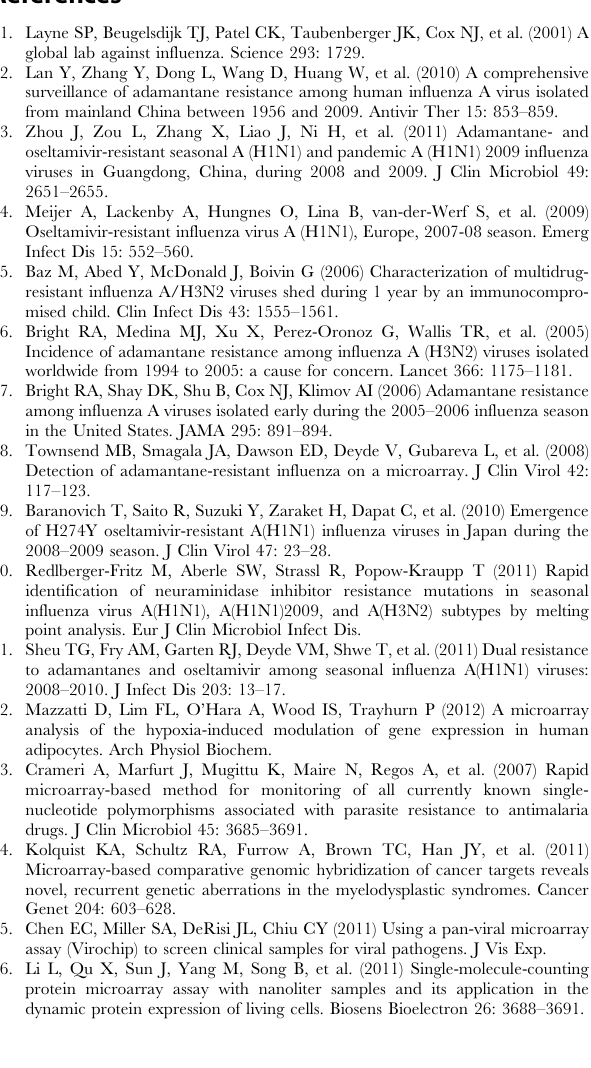
sequencing using BigDye terminator cycle sequencing kit,